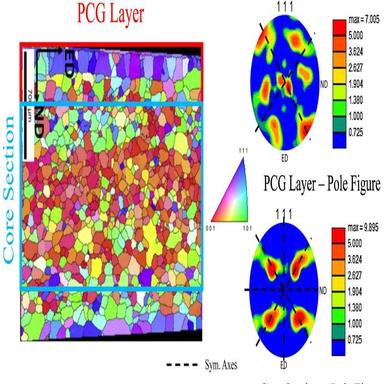
13. Through-thickness microstructure of AA6063-T6 material (adapted from et al., 2019).